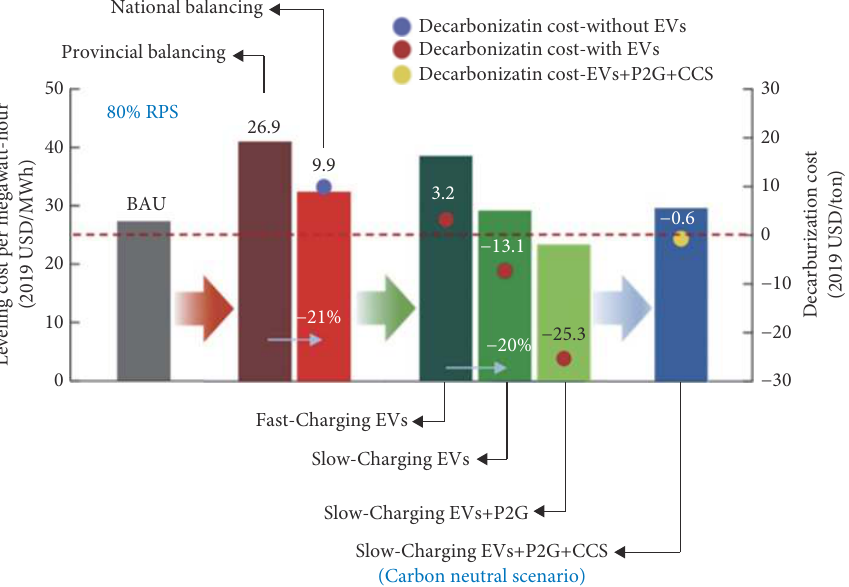
Fig. 1 Decarbonization costs across different scenarios for China in 2050 at 80% renewable energy penetration (reprinted with permission from ref. [1], © 2021 Elsevier Inc.